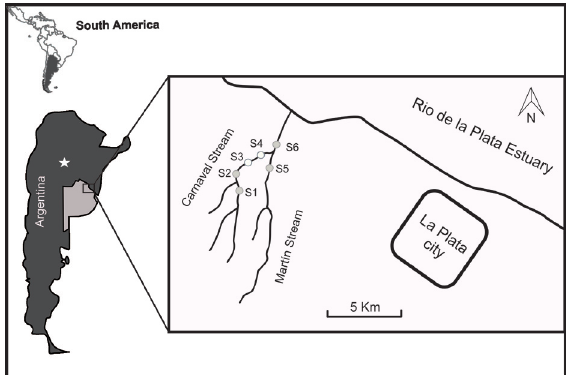
Figure 1 - Study area.S1-6: Sites where Sinotaia cf quadrata was searched (white spots indicate where the species was present). The star in the map of Argentina indicates the area where S. quadrata was first recorded in Córdoba, Argentina, according to Ovando and Cuezzo